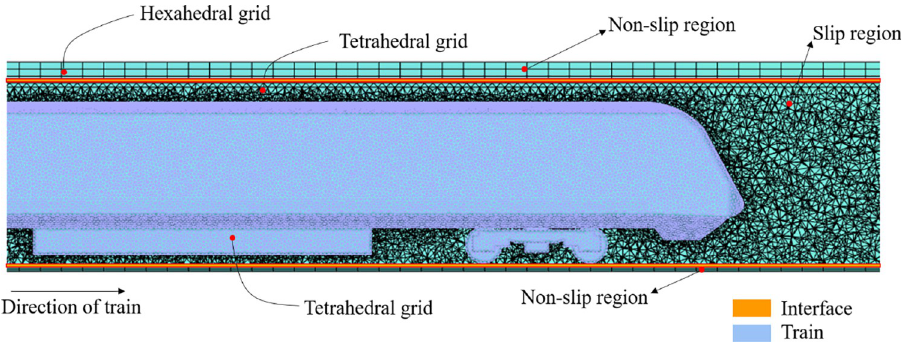
Fig 3. Local grids in the computational